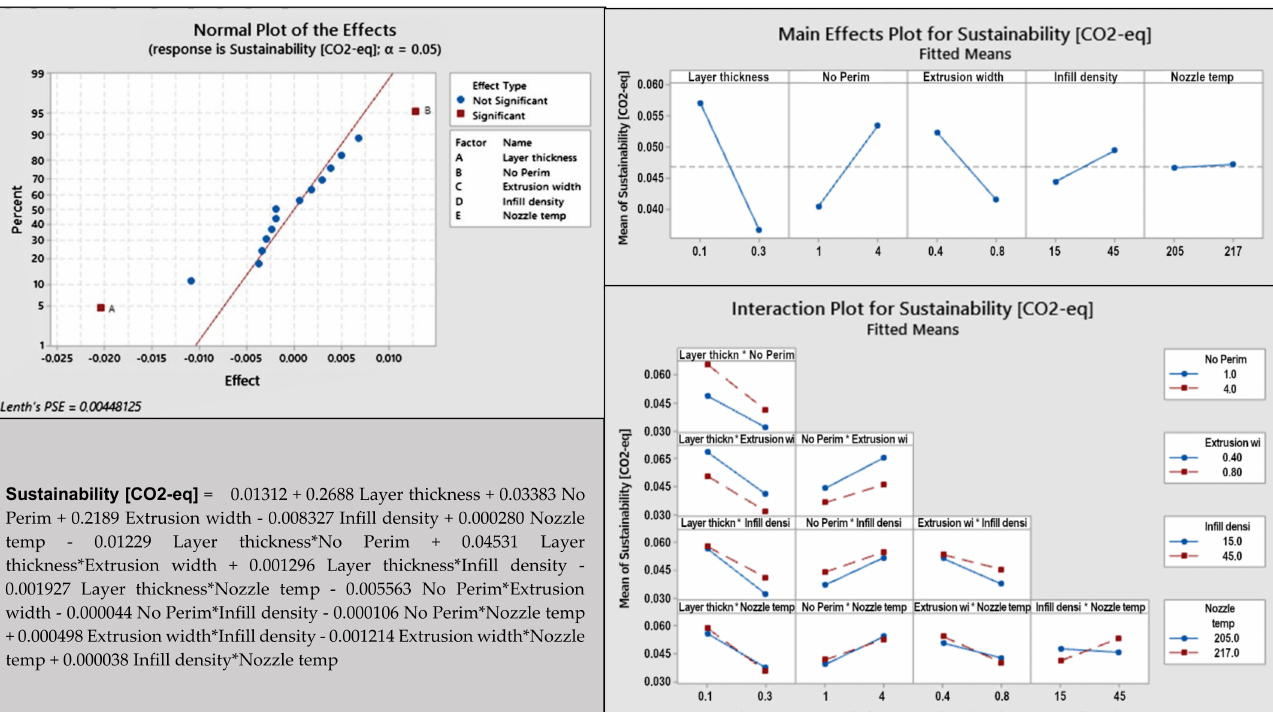
Figure 8. Graphical presentation of sustainability results for PLA.